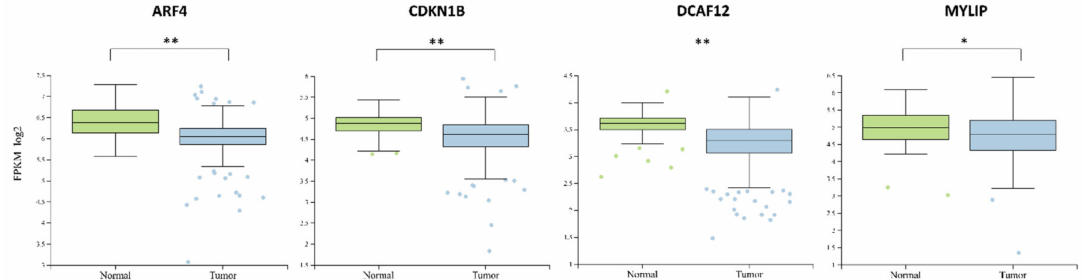
Figure 6. mRNA expression comparison between normal and cancerous tissue groups of the major genes modulated by miR-222. The box squares represent the data within 25 and 75 percentiles, line in the middle shows the median, the outliers are shown as dots. * p < 0.05, ** p < 0.0001. A total of 560 cases analyzed (normal n = 58, tumor n =